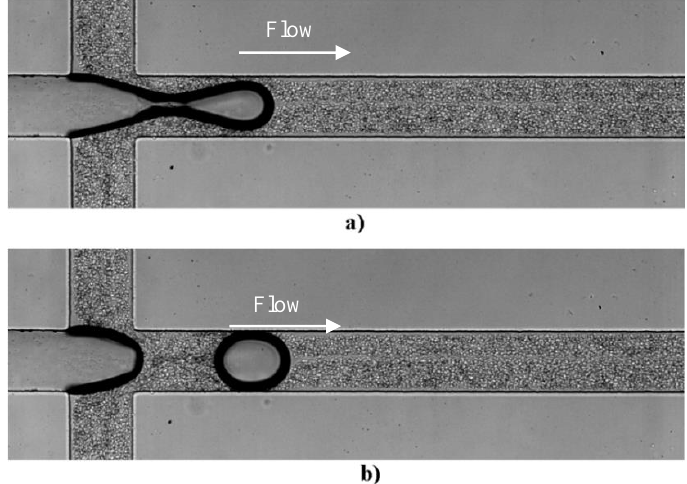
Figure 3. Sequential images of the formation of an air bubble: ( a ) bubble before detachment and ( b ) bubble after detachment (see Supplementary Video 1).